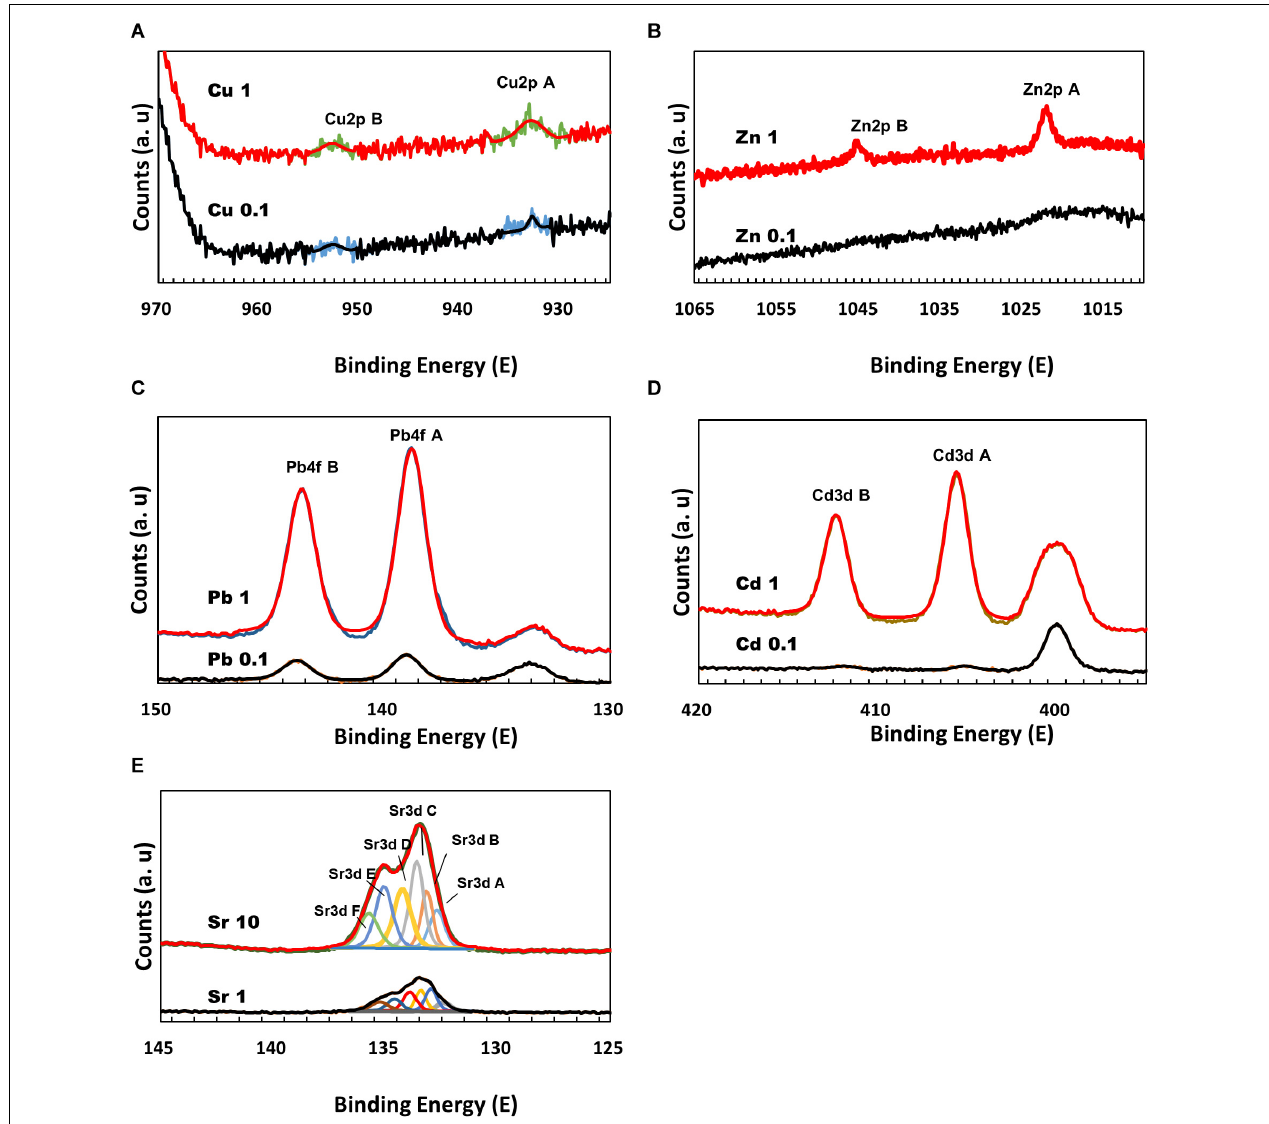
FIGURE 5 | X-ray photoelectron spectroscopy spectra of calcium carbonate precipitated at a range of metal concentrations: Cu 2p (A) ; Zn 2p (B) ; Pb 4f (C) ; Cd 3d (D) ; and Sr 3d (E)